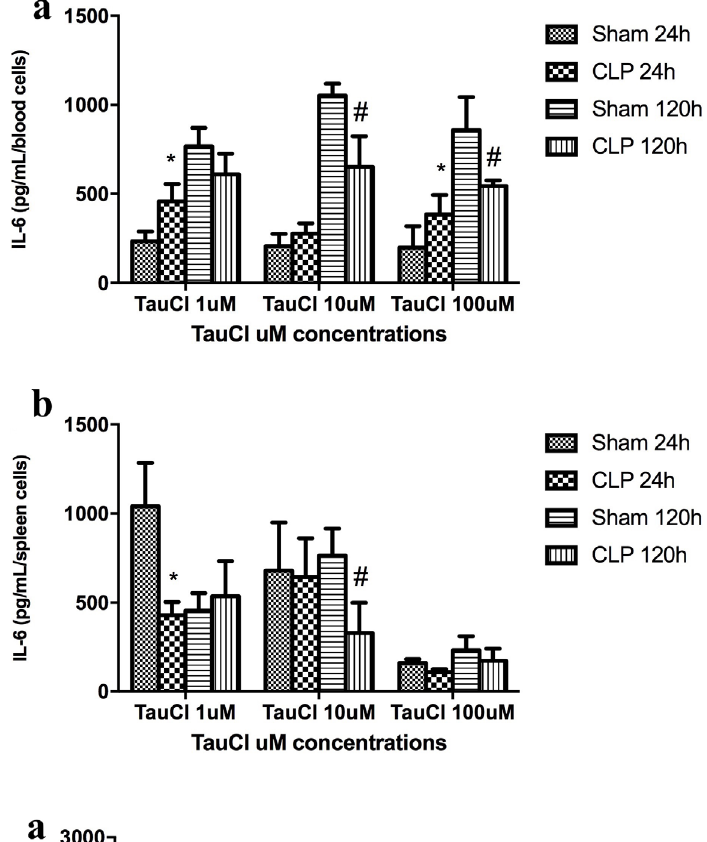
Figure 7. The effect of TauCl on the production of the pro-inflammatory mediator, IL-10. Lymphocytes (1x106 cells/mL) were preincubated with TauCl (1, 10 or 100 uM) for 1 hour. After this, supernatants were collected and IL-10 was measured by ELISA for (a) blood and (b) spleen. Results are expressed as means ± SD. * = P < 0.05 compared with sham rats 24 hours. # = P < 0.05 compared with sham rats 120 hours